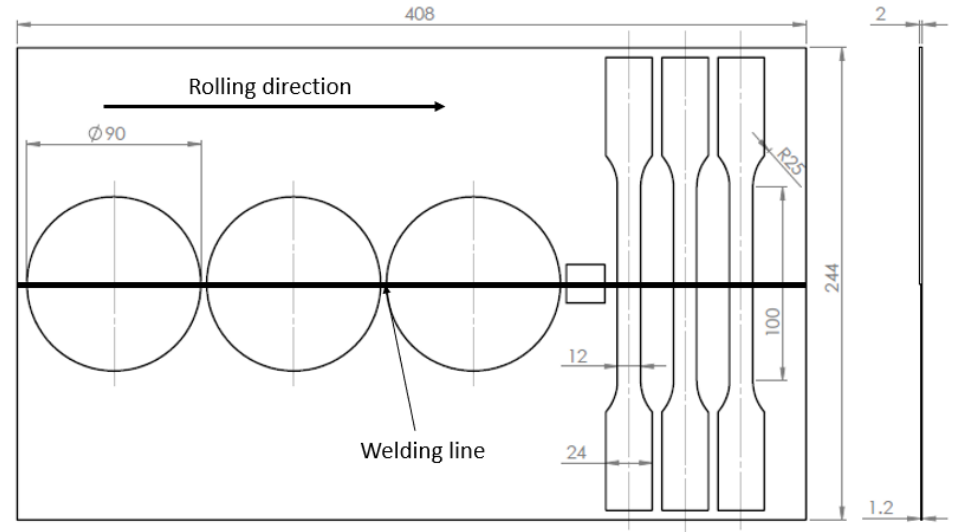
Figure 2. Sampling scheme of the specimens used in the metallographic examination and mechanical (tensile and Erichsen) tests.